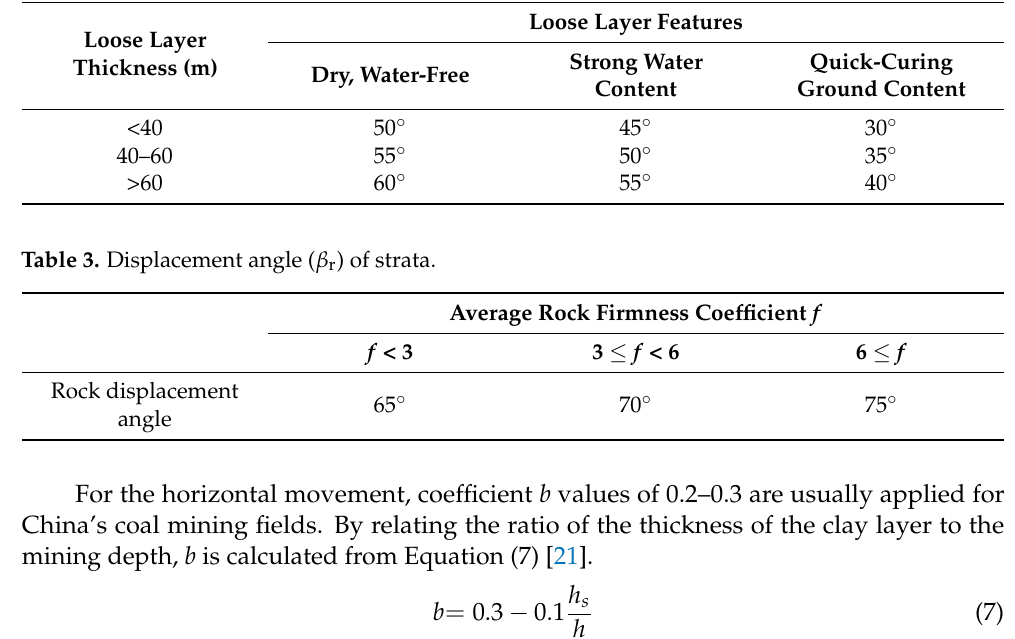
Table 2. Displacement angle ( β s ) of loose layer.